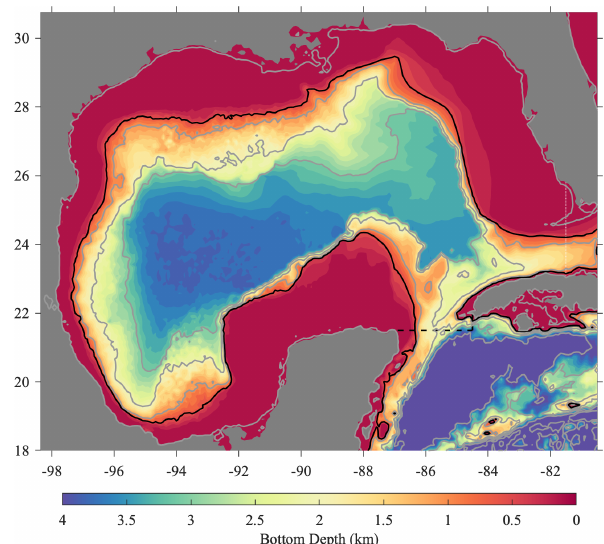
Figure 1. Bottom depth in the Gulf of Mexico, in kilometers. The region within which drifter trajectories are extracted is bounded by 80.5 ◦ W to the east, the right-hand edge of this plot, and in the Yu- catán channel by the dotted line extending east from the Yucatán Peninsula along 21.5 ◦ N and turning north to Cuba at 84.5 ◦ W. The heavy black contour is the 500m isobath, while the gray contours mark the 5m isobath as well as those at 1, 2, etc., km. Subsequent plots will extend eastward only to 81.5 ◦ W, the dashed white line reaching from Florida to